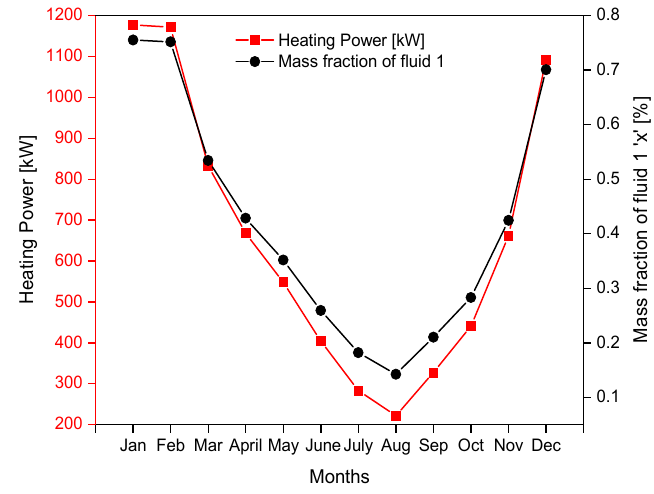
Figure 7. Monthly heating power and mass fraction of fluid 1 ‘x’.